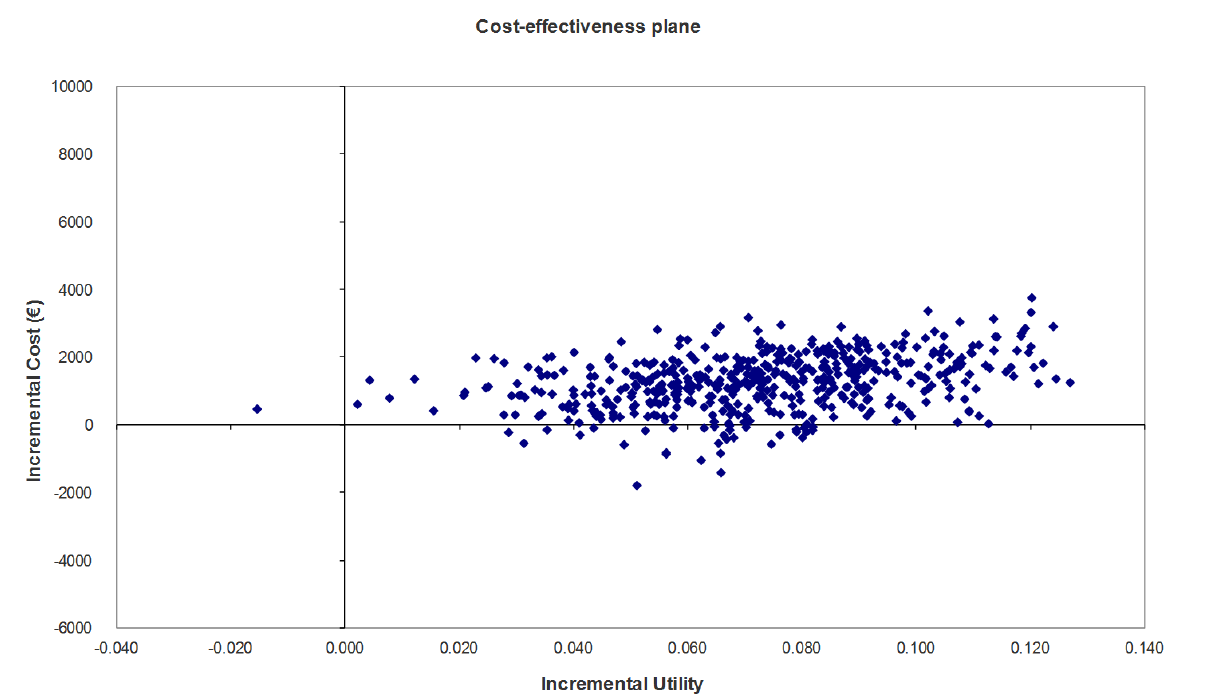
Figure 3. Probabilistic Sensitivity Analysis